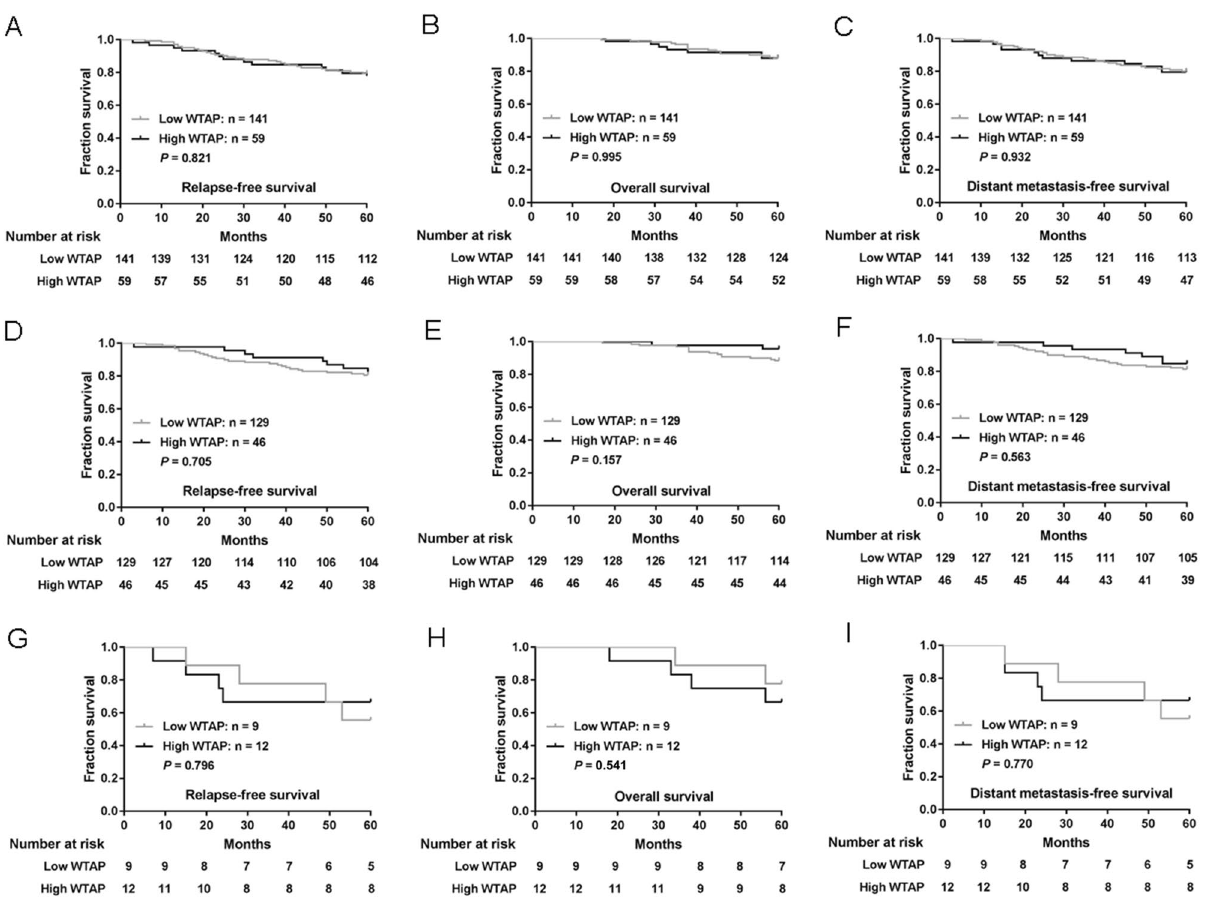
Figure 2. ( A - C ) The associations of WTAP expression with relapse-free survival (RFS) (A), overall survival (OS) (B) and distant metastasis-free survival (DMFS) (C). ( D - F ) The associations of WTAP expression with RFS (D), OS (E) and DMFS ( F ) of patients with non-TNBC. ( G - I ) The associations of WTAP expression with RFS (G), OS (H) and DMFS (I) of patients with TNBC. P -values were calculated using the Mantel-Cox log-rank